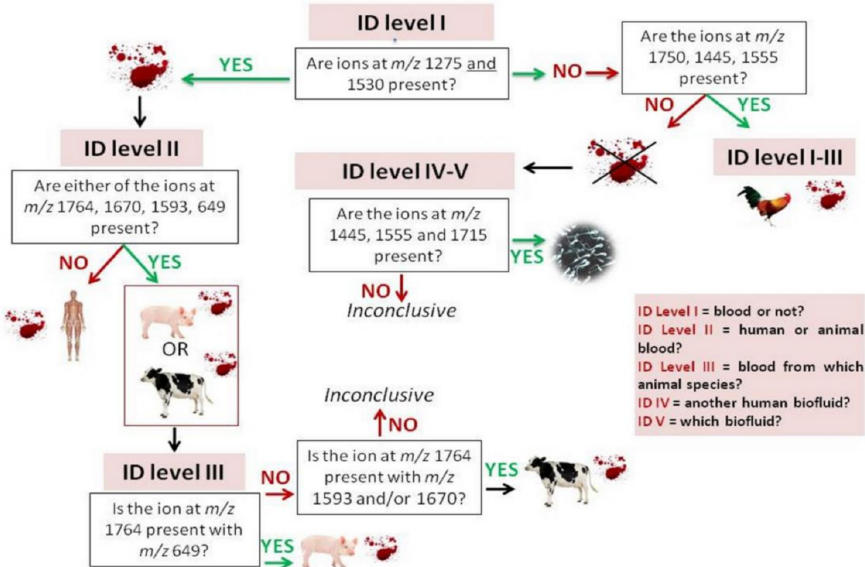
Figure 5. Interpretative strategy to identify blood samples (from human and animal species) and semen using matrix assisted laser desorption ionization mass spectrometry (MALDI MS). Identifi- cation (ID) levels I–III were for animal provenance (down to species) and ID levels IV-V were for